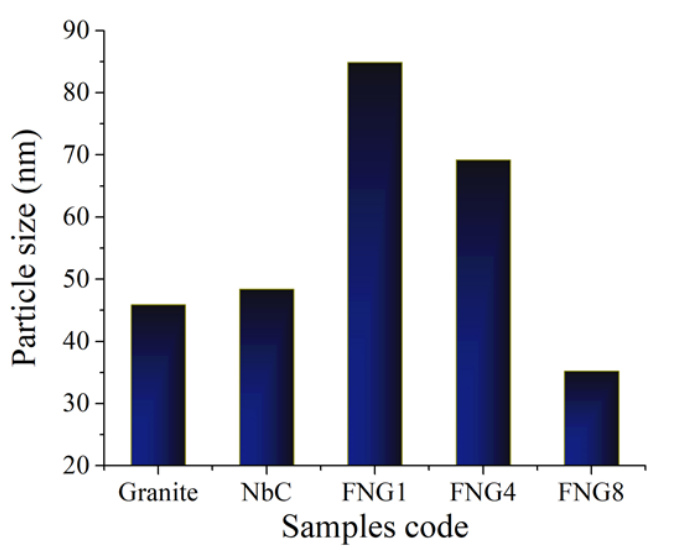
Figure 6. The effect of added hybrid reinforcements on the particle size of the Fe alloy matrix.